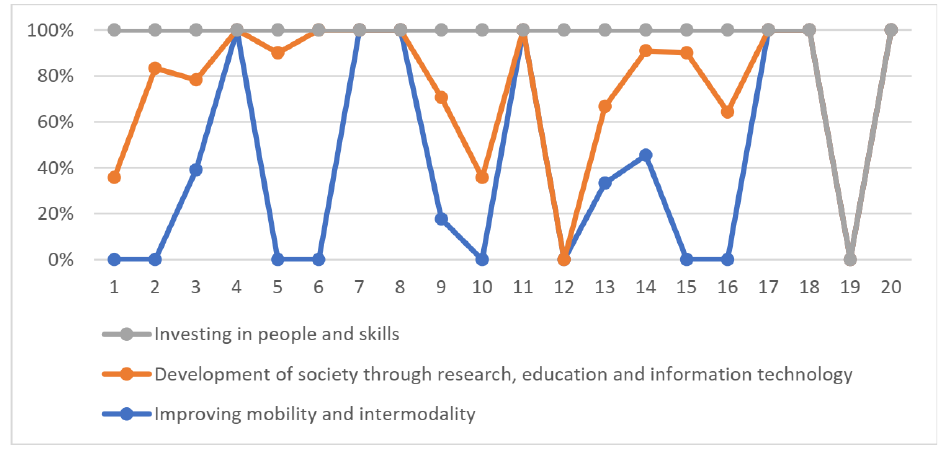
Figure 4. Contribution measures taken by the European Commission to remove barriers identified by